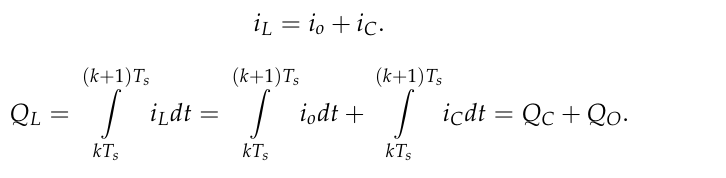
Figure 3. In this interval, the DC capacitor C dc 1 charges the filter capacitor C and supports